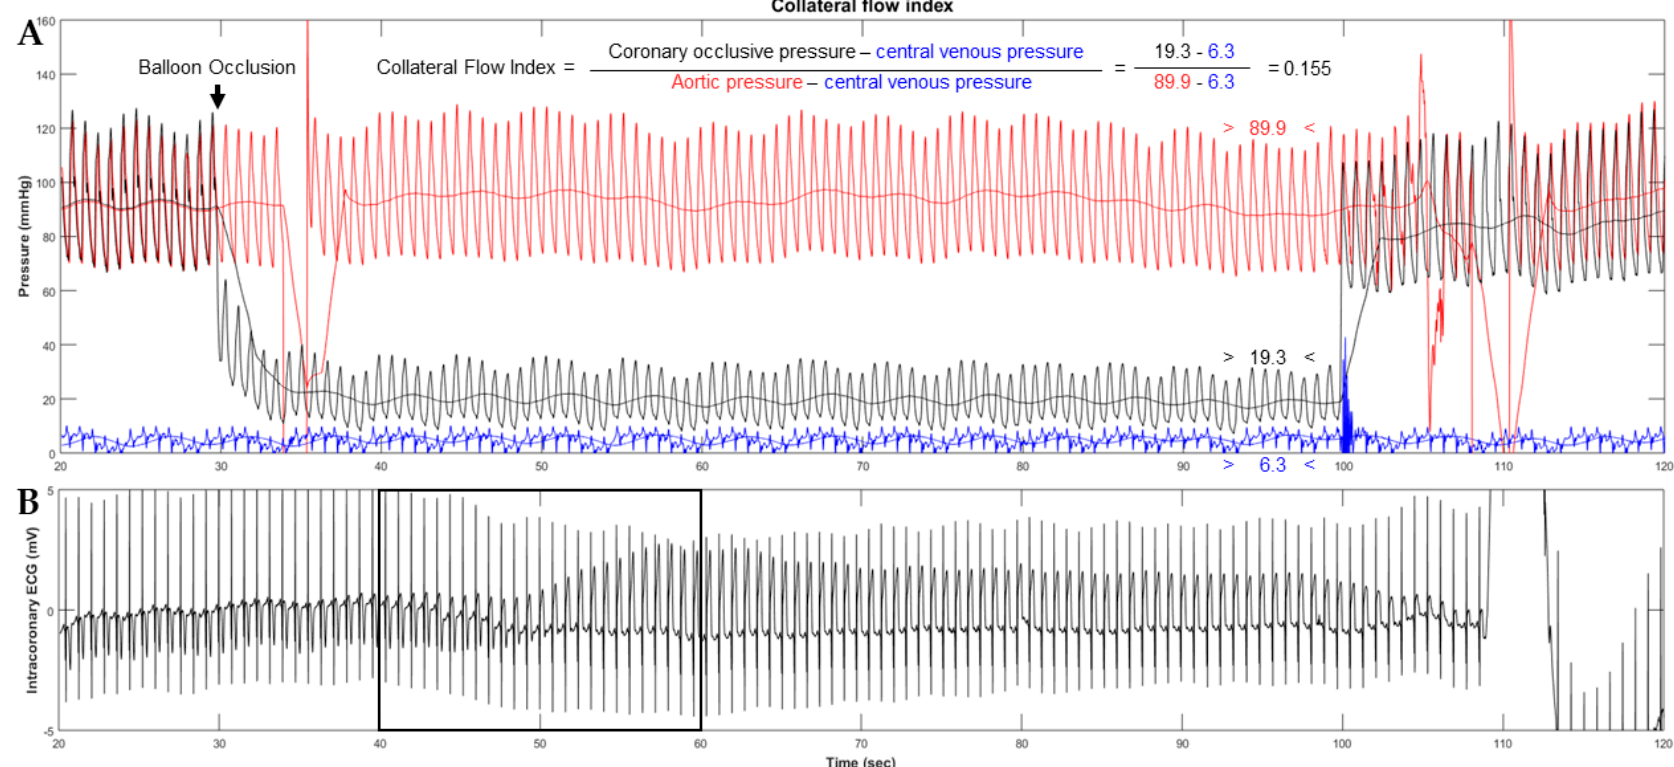
Figure 3. Collateral flow index (CFI) measurement. ( A ) Simultaneous recordings of mean and phasic aortic (red signals, Pao), coronary occlusive (black signals, Poccl) and central venous pressure (blue signals, CVP) immediately before (left side) and during coronary artery occlusion in a patient with poorly functional collaterals. ( B ) Detection of myocardial ischemia during the coronary artery occlusion by the intracoronary electrocardiogram (i.c.ECG). Immediately after balloon occlusion, the i.c.ECG shows marked electrical alternations with flipped T-waves and ST-segment elevation (marked by the black square). Generally, a CFI of > 0.20–0.25 is related to absent signs of ischemia on i.c.ECG during a 1-min proximal coronary occlusion.